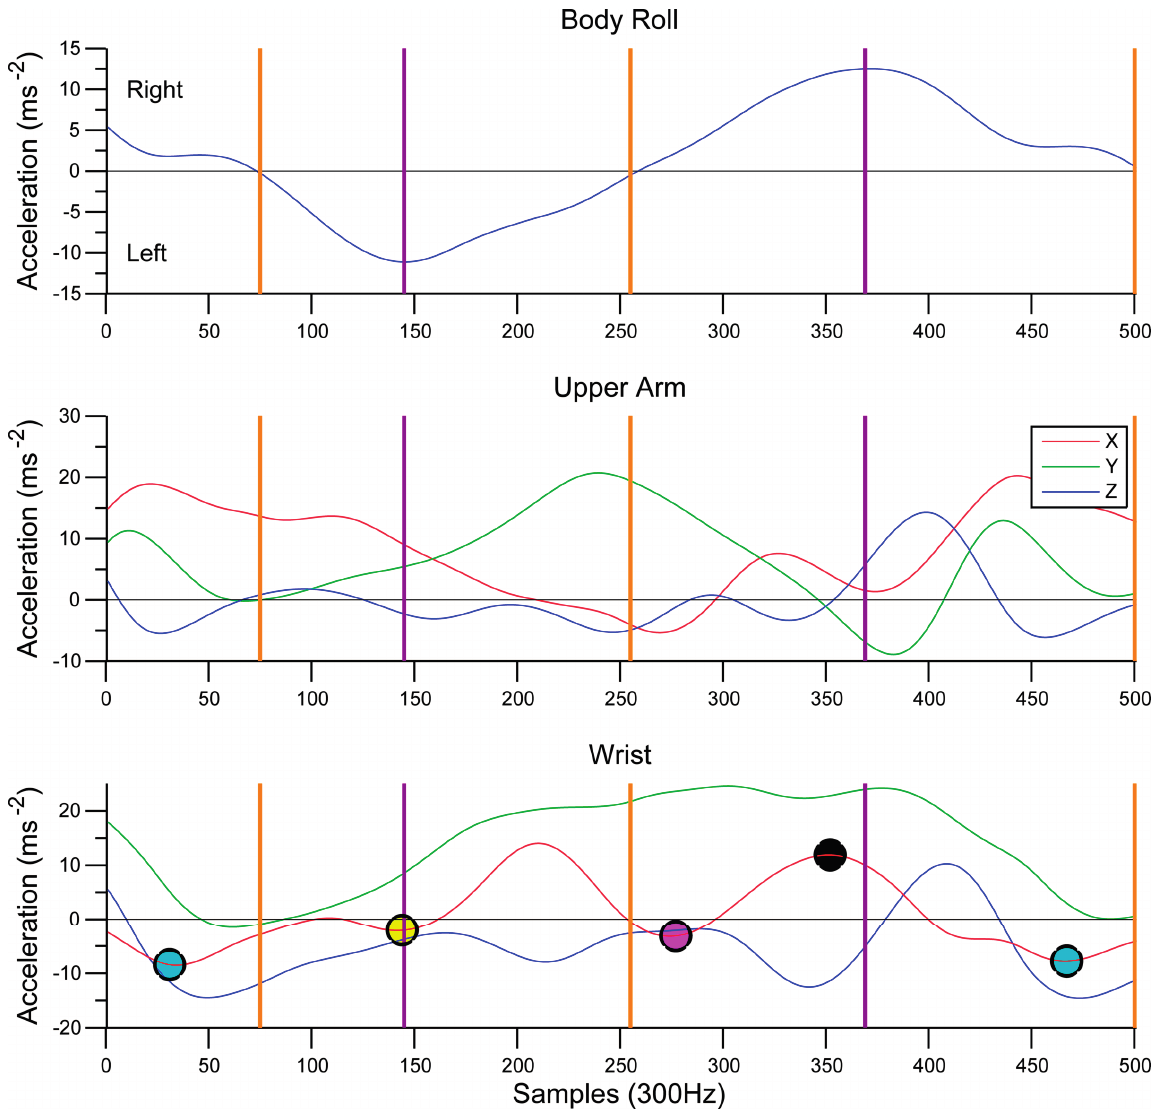
Figure 4. Identification process of the phases in the stroke (Swimmer R). Entry (Cyan dot), Start of Pull (Yellow dot), Start of Push (Magenta dot), Start of Recovery (Black dot). Zero Crossing Body Roll (Orange), Peak Body Roll